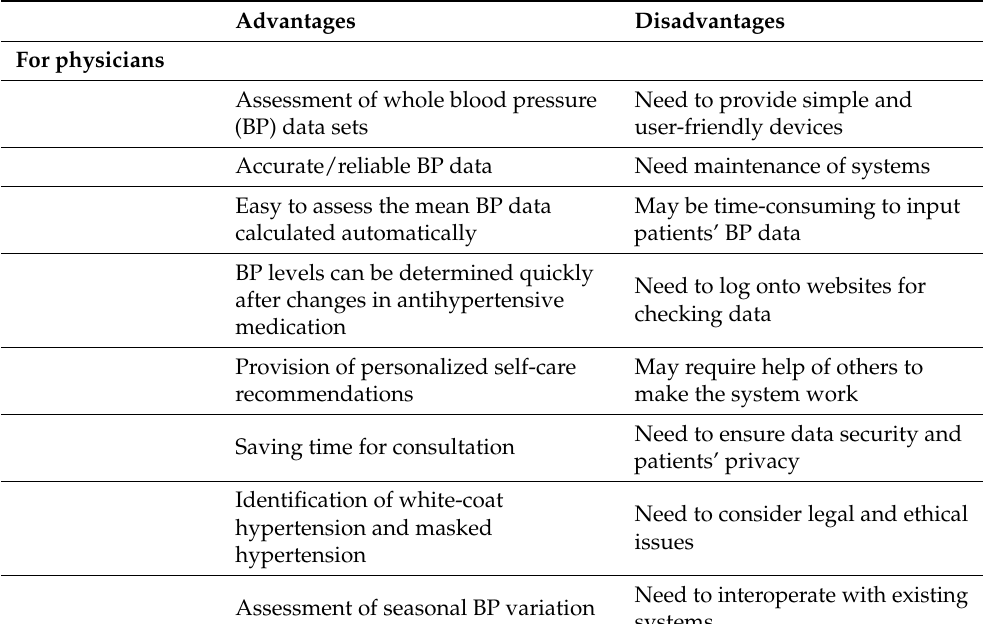
Table 1. Advantages and disadvantages of blood pressure telemonitoring system for the management of hypertension in older